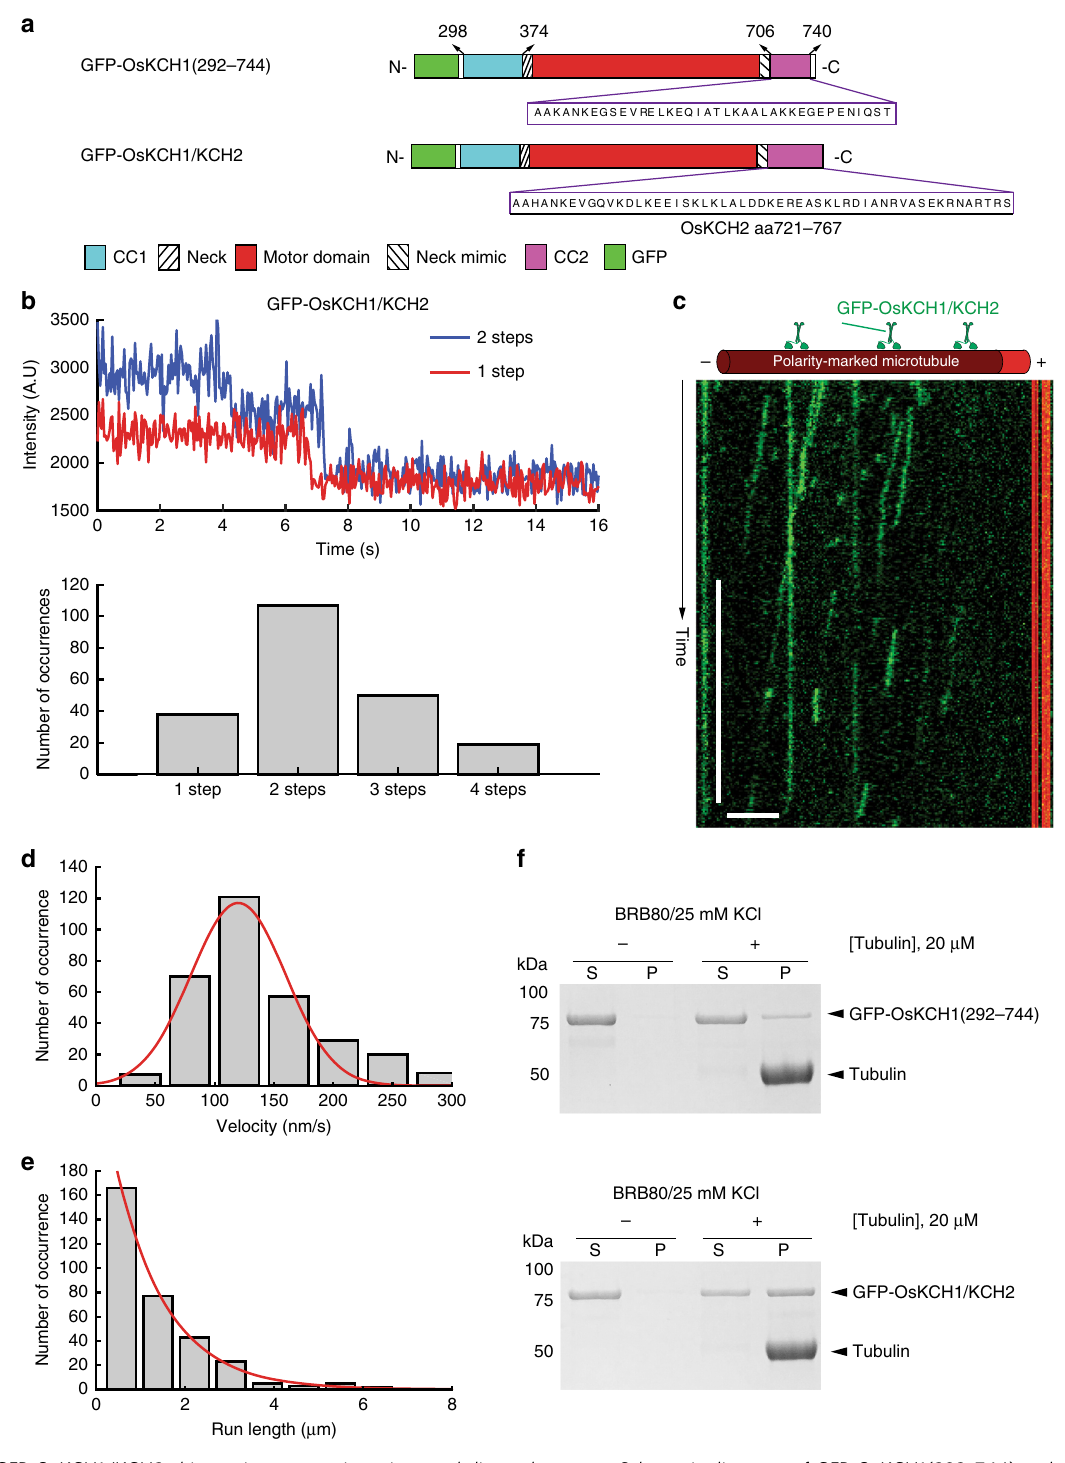
Fig. 5 The GFP-OsKCH1/KCH2 chimera is a processive minus-end-directed motor. a Schematic diagrams of GFP-OsKCH1(292 – 744) and the GFP- OsKCH1/KCH2 chimera. GFP-OsKCH1/KCH2 is a derivative of GFP-OsKCH1(292 – 744) by replacing its endogenous CC2 with that from OsKCH2. b Photobleaching analyses of GFP-OsKCH1/KCH2. (Top) Example fl uorescence intensity traces over time of individual GFP-OsKCH1/KCH2 molecules immobilized on the microtubules. (Bottom) Histogram of the photobleaching steps of GFP-OsKCH1/KCH2 ( n = 214). c Example kymograph of individual GFP-OsKCH1/KCH2 molecules (green) moving processively toward the minus end of single polarity-marked microtubules (red). d Velocity histogram of single GFP-OsKCH1/KCH2 molecules. Red line indicates a Gaussian fi t to the velocity histogram. e Run-length histogram of single GFP-OsKCH1/KCH2 molecules. Red line indicates a single-exponential fi t to the run-length histogram. f Coomassie-stained SDS-PAGE of the microtubule co-sedimentation assay for (top) GFP-OsKCH1(292 – 744) and (bottom) GFP-OsKCH1/KCH2 in BRB80/25 mM KCl. Scale bars: 30 s (vertical) and 5 µ m